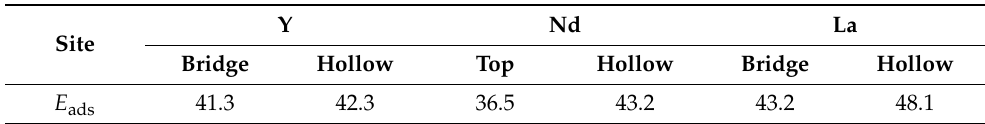
(cid:0) (cid:1) 001